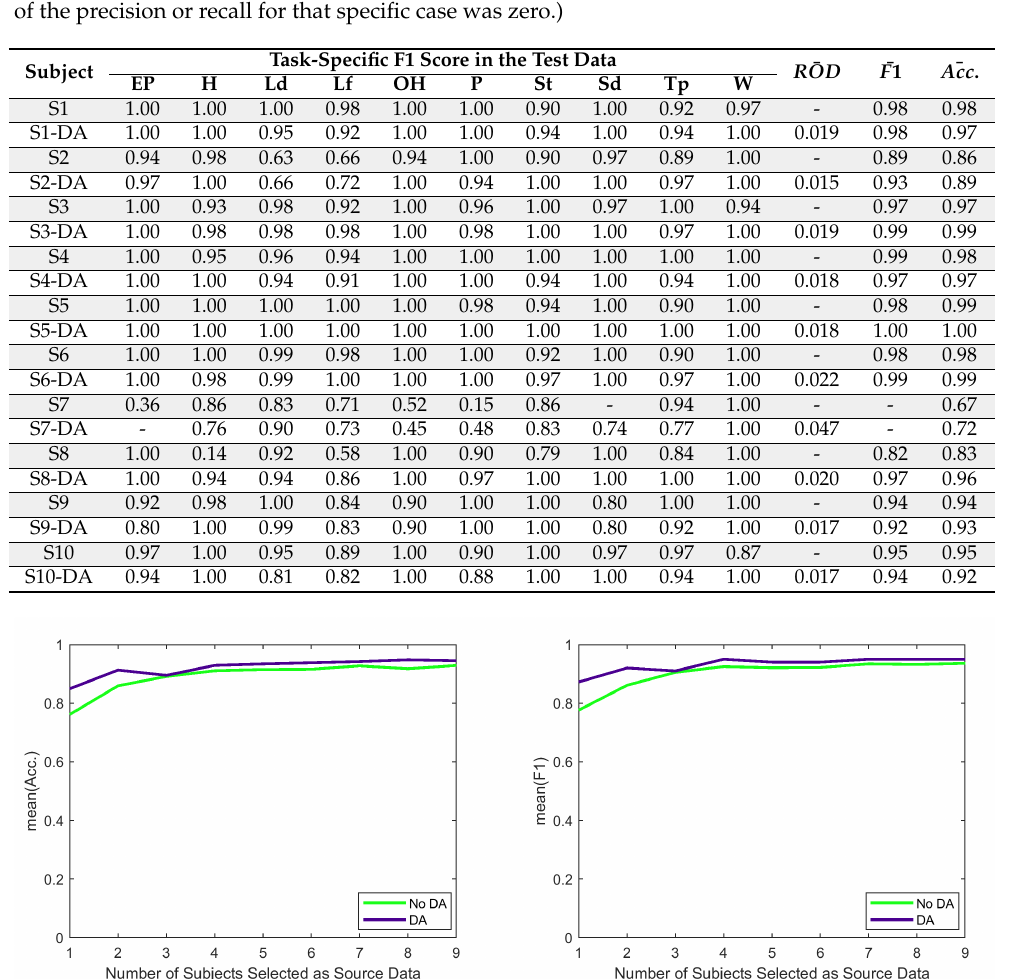
Table 4. Cross-subject classification performance. Abbreviations: EP: electrical panel, H: hoisting, Ld: ladder, Lf: lifting; OH: overhead; P: pushing; St: sitting; Sd: standing; Tp: typing; W: walking (For some of the cases, “-” has been reported as task-specific F1 score, which means that the denominator of the precision or recall for that specific case was zero.)